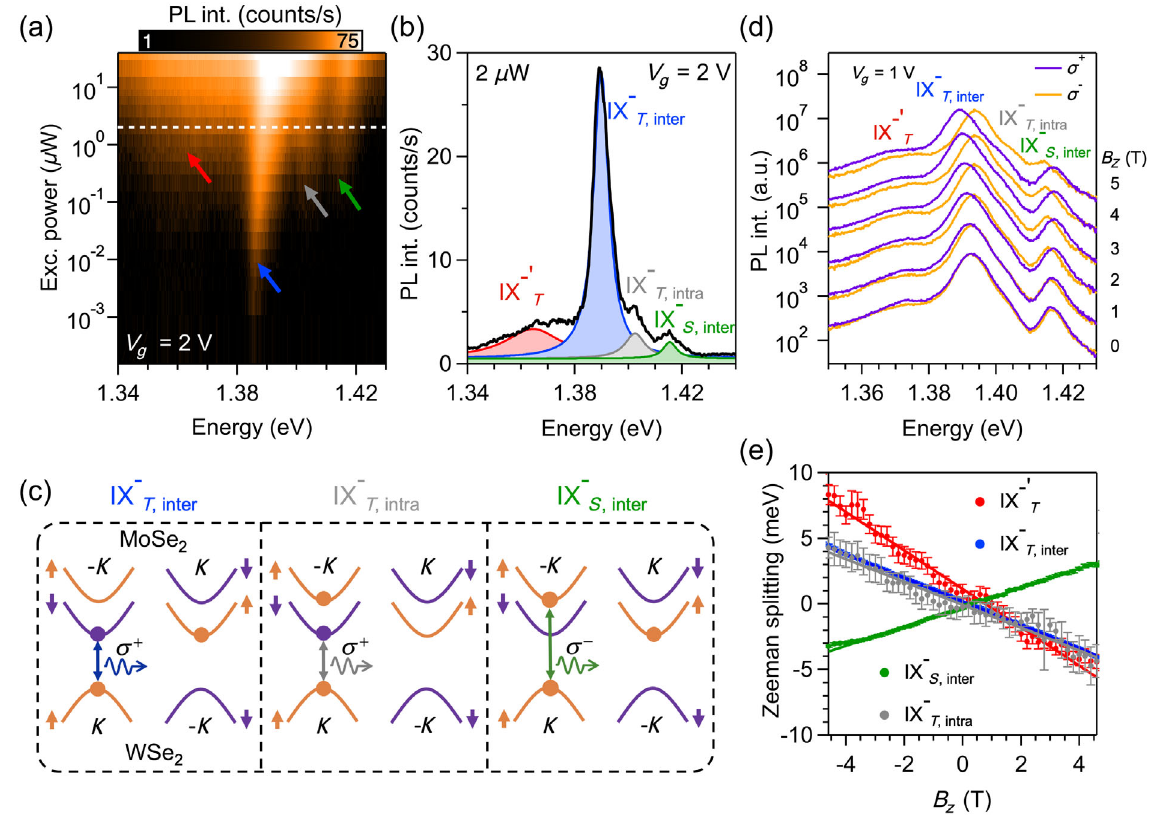
FIG. 4. Interlayer exciton trions in WSe 2 = MoSe 2 . (a) Color plot with the full evolution of the PL spectrum of negative IX trions for 0 . 2 nW ≤ P ≤ 40 μ W at V ¼ 2 V in logarithmic scale, in which four different peaks can be resolved (as indicated by the arrows). g exc ¼ 2 V, fitted to four value indicated by the white dashed line in (a) ( 2 μ W) at V (b) PL spectrum acquired for the intermediate P g exc (blue), IX − (gray), IX − (green), and IX − 0 (red). (c) Schematic Lorentzian peaks corresponding to various exciton species: IX − T T; inter T; intra S; inter representation of the charge configurations for IX − (left), IX − (middle), and IX − (right) showing the optical transitions that T; inter T; intra S; inter involve a hole in the topmost valence band of WSe 2 at K . (d) Magnetic field dependence of the IX trions PL for σ þ - (purple) and σ − - ≤ 5 T under V ¼ 1 V and P ¼ 40 μ W. (e) Zeeman splitting of each IX trion polarized (orange) collection in the range 0 ≤ B z g exc species (dots) as extracted from fits of the experimental data shown in (d). The solid lines represent linear fits of the experimental